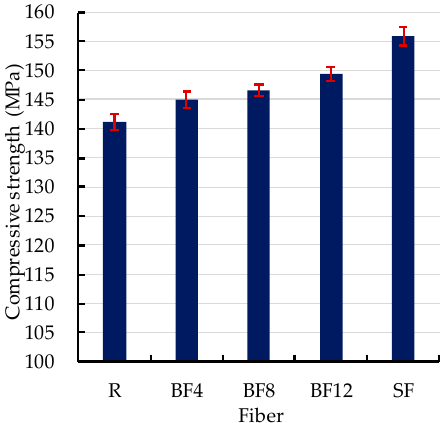
Figure 4. E ff ect of basalt fiber content and fiber type on the compressive strength of Figure 4. Effect of basalt fiber content and fiber type on the compressive strength of RPC.